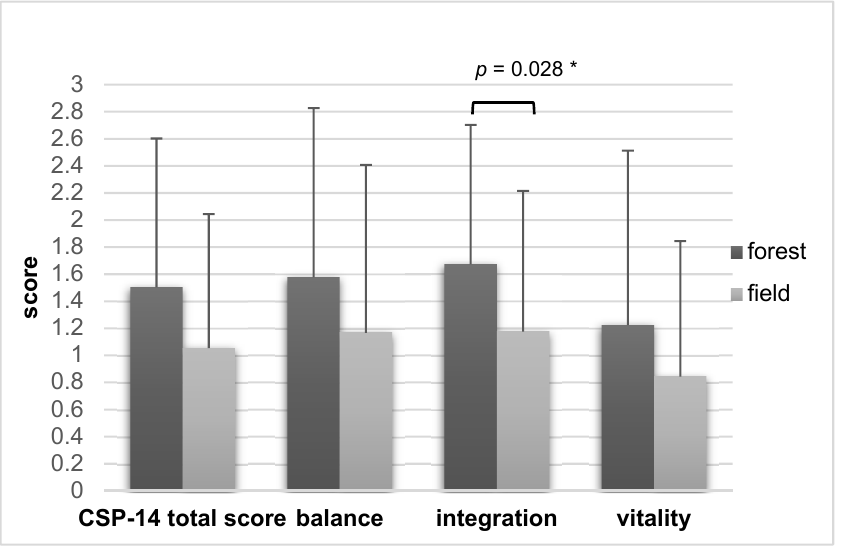
Figure 2. CSP-14 of the ITT total collective ( n = 39, mean values ± standard deviation), comparison of forest and field interventions. * = p < 0.05.